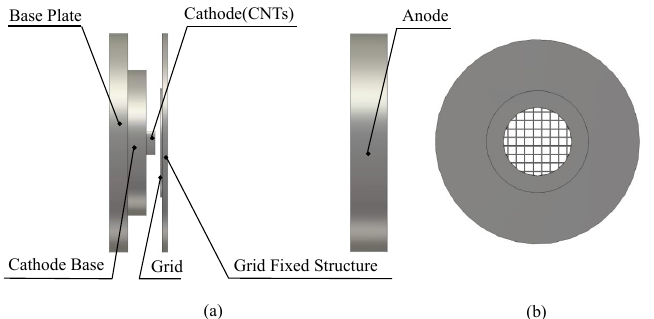
Figure 1. ( a ) Three-dimensional-structure model of cold cathode emission. ( b ) Grid mesh